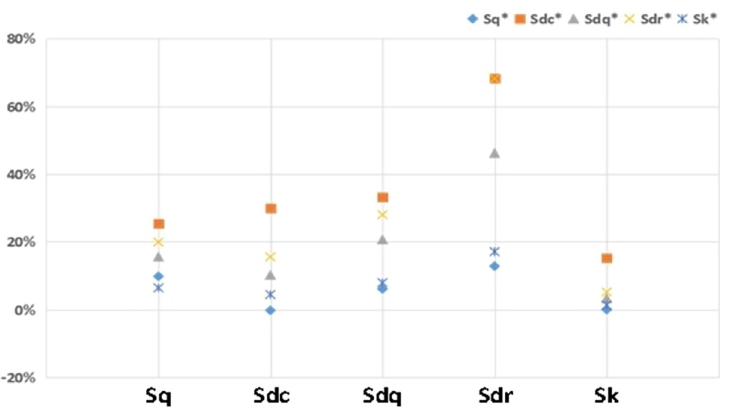
Fig 9. The change rate of the parameters in